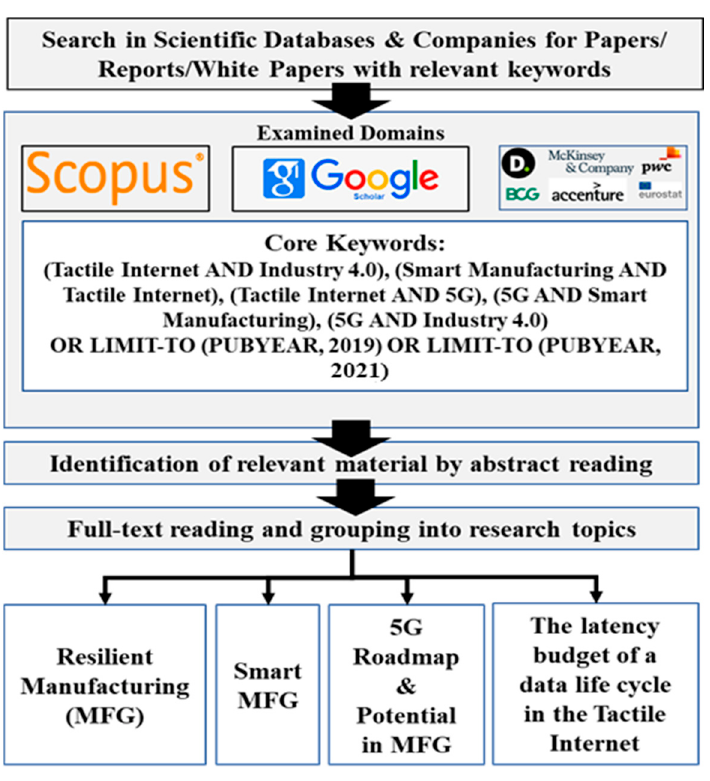
Figure 4. Research Methodology for Literature Review.